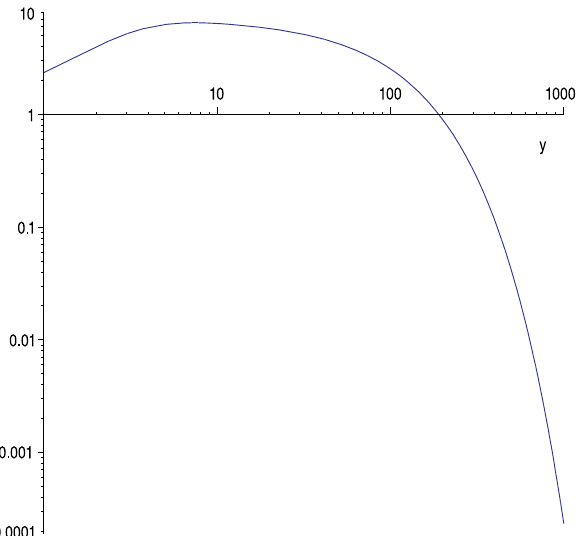
Fig. 6 Full propagator for μ = 1 and λ = 1 / 3 as a function of y with both axes given in the logarithmic